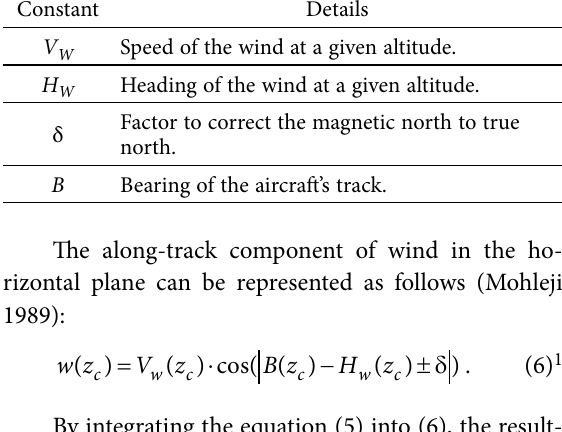
Table 1. Constants and variables of wind effect equations Constant Details Speed of the wind at a given